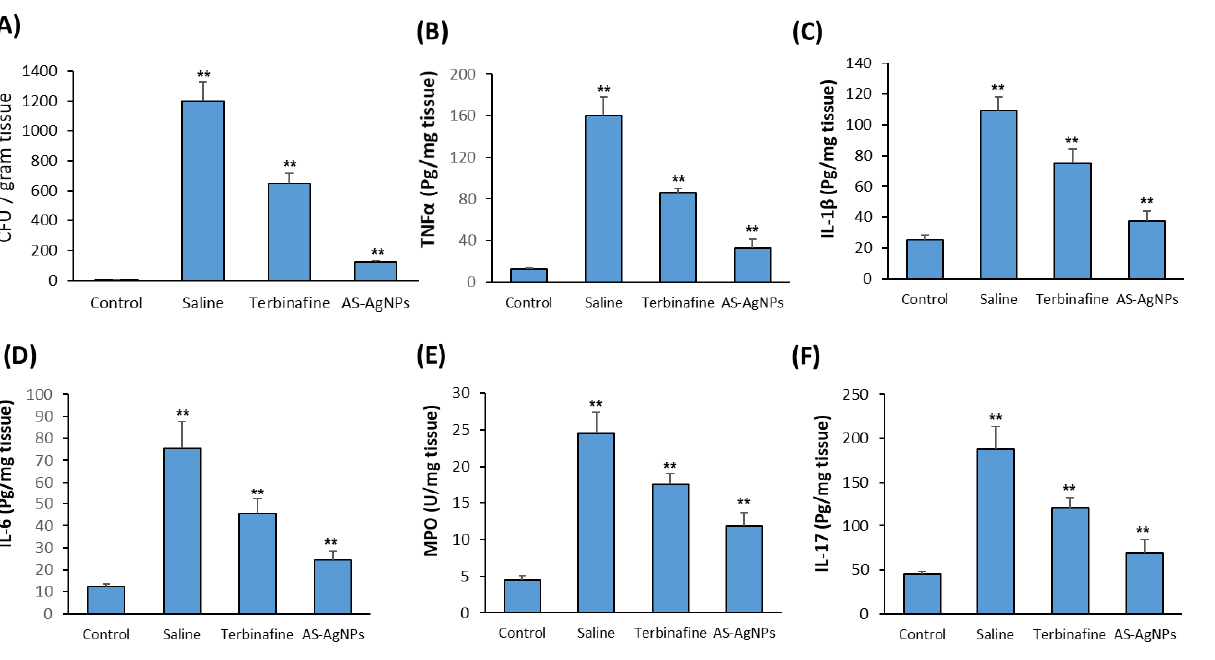
Figure 8. Effect of AS-NPs on fungal burden and dermal pro-inflammatory cytokines in dermato- phytosis rat model. ( A ) Inhibitory effect of AS-AgNPs versus trebinafine treatment on colonization of T. rubrum in infected skin homogenate after 14 days of treatment. Infected rats with T. rubrum were treated for 14 days with saline, terbinafine (10 mg/kg) or topically with AS- AgNPs (0.5 μg/g. Effect of AS-AgNPs versus trebinafine treatment on the pro-inflammatory cytokines produced in the infected skin tissues of the dermatophytosis rat model. The following cytokines, including ( B ) TNF- α, ( C ) IL- 1β, ( D ) IL-6, ( E ) MOP and ( F ) IL-17, were measured as described in M&M. Values are expressed as means ± SD (n = 6 rats/group) (** p < 0.005, compared to control non-infected cells).